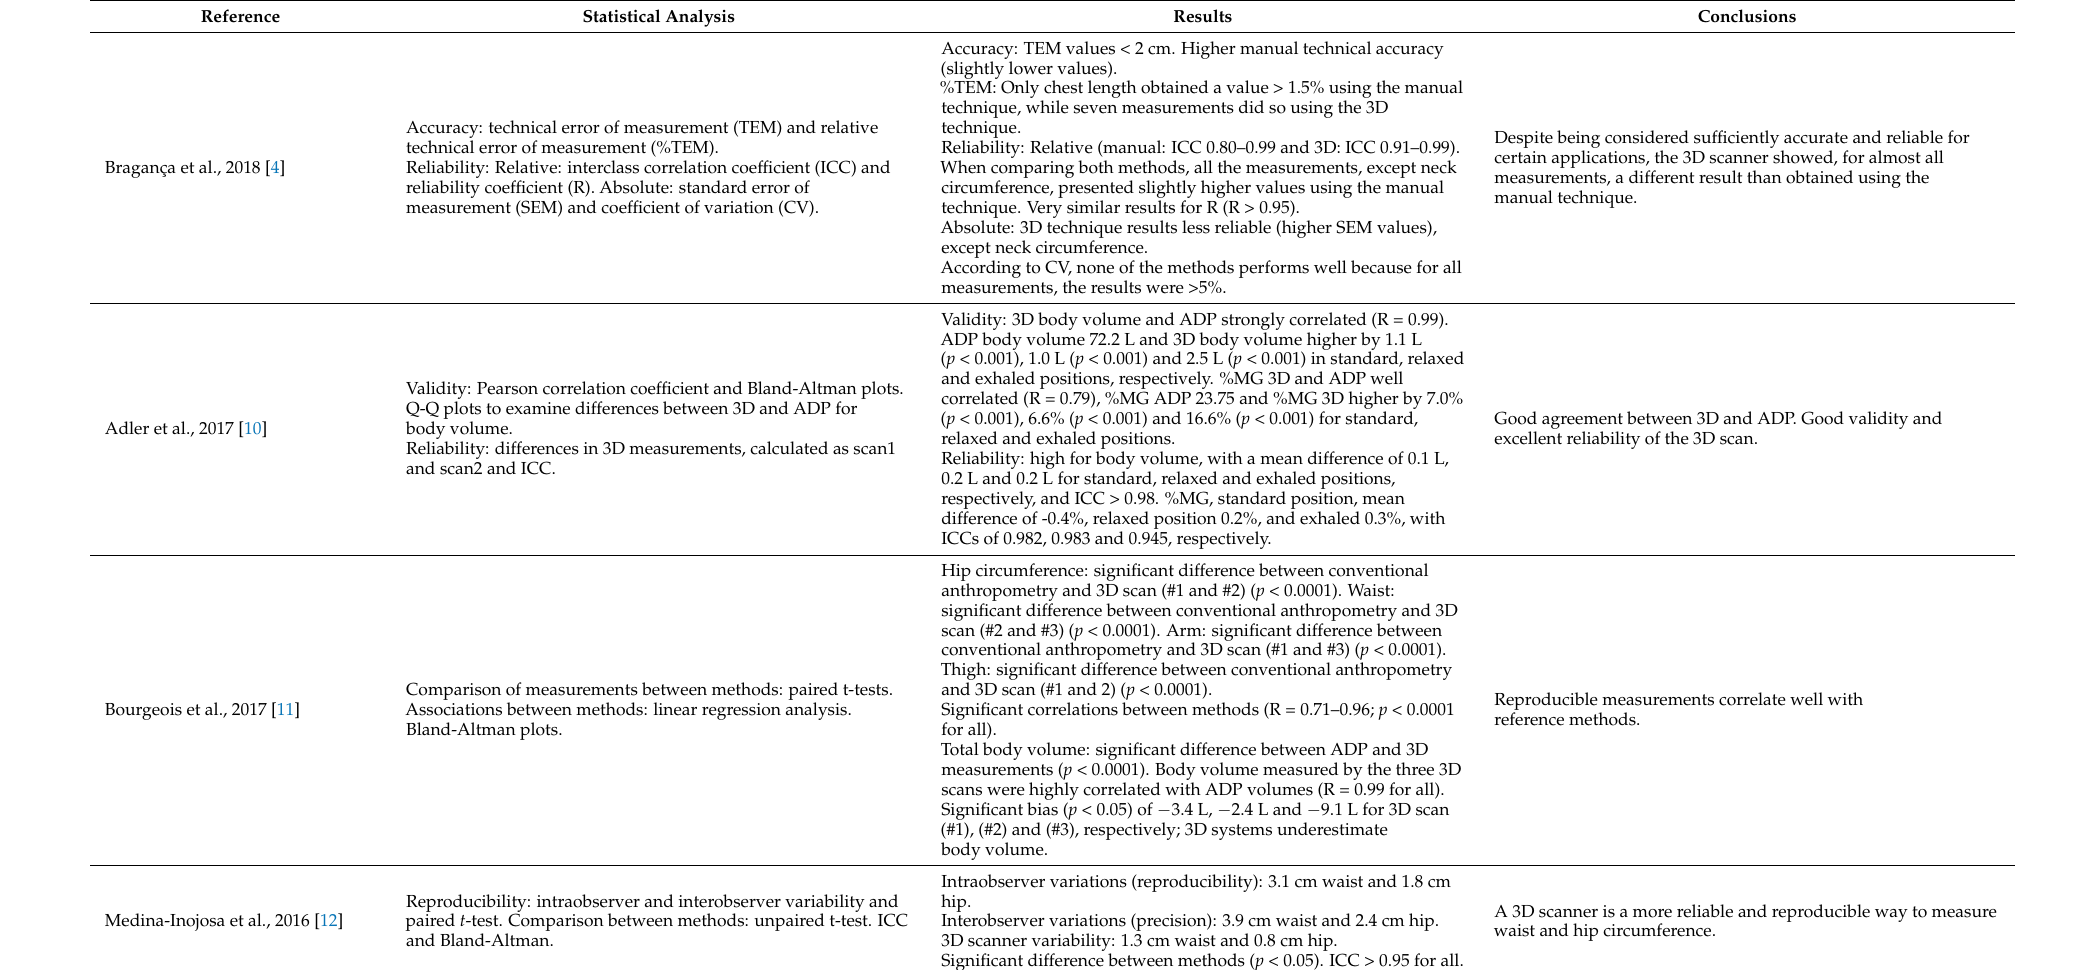
Table 5. Statistical analysis, results and conclusions of the included